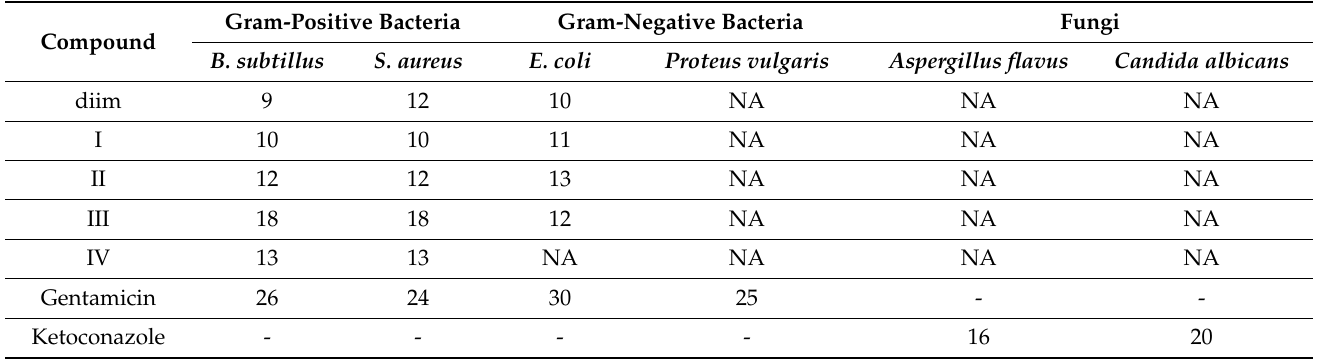
Table 5. Biological evaluations for diim ligand and its metal complexes at 10